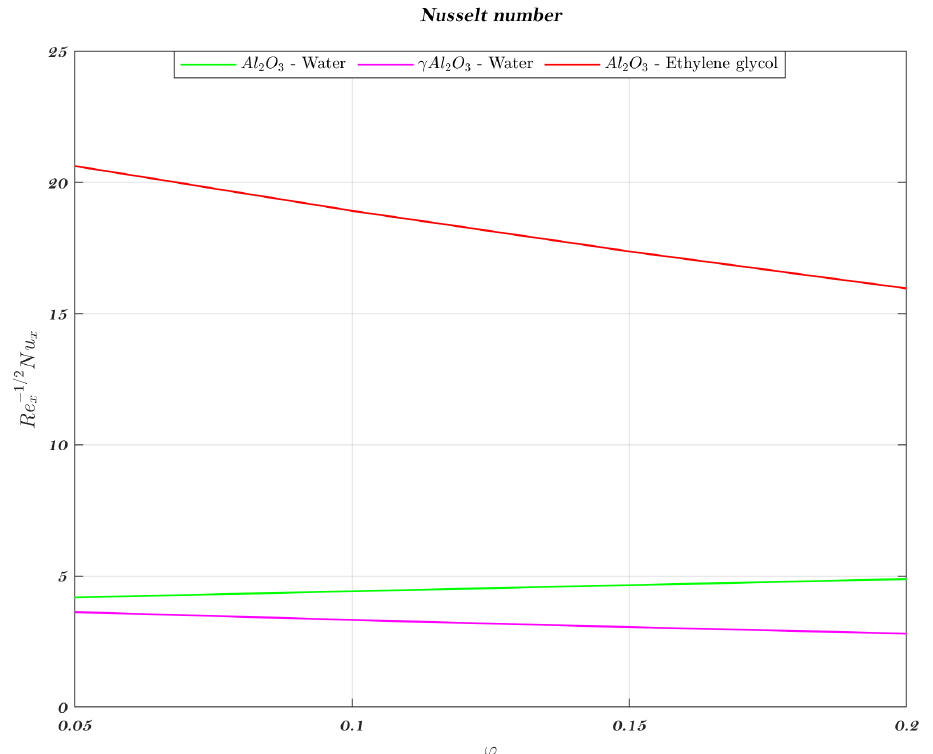
Figure 21. Impact of ϕ on Nusselt